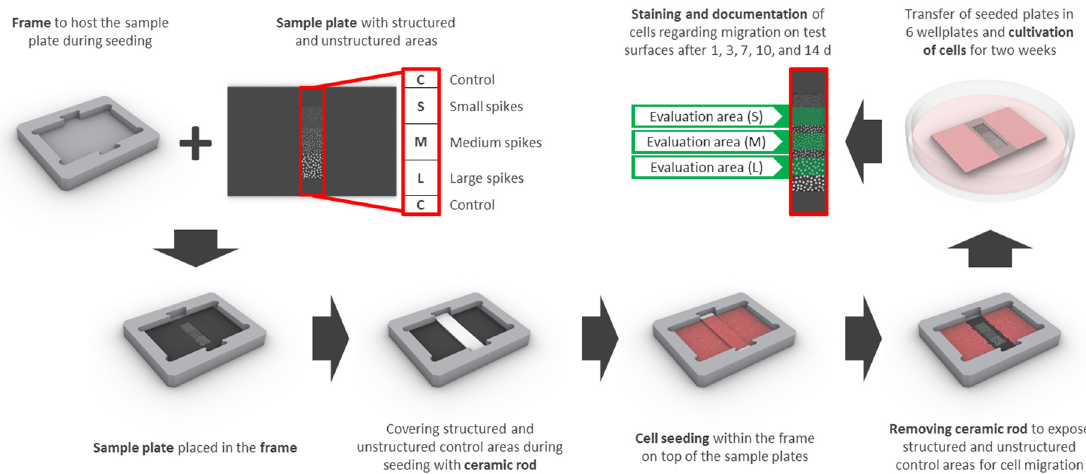
Figure 9. The design for the migration assay includes a sample plate with structured (small (S), medium (M), and large (L) spikes) as well as unstructured control areas (C) surrounding the structures and a frame, which serves as a placeholder for the sample plate and the ceramic rod. The areas of interest are covered with the ceramic rod before cell seeding and uncovered after initial adhesion to enable migration for 14 days. Quantification of stained cells was performed consecutively after 1, 3, 7, 10, and 14 days only in the designated structured areas (evaluation area (S), (M), or (L) in green) in order to avoid interference from adjacent areas.